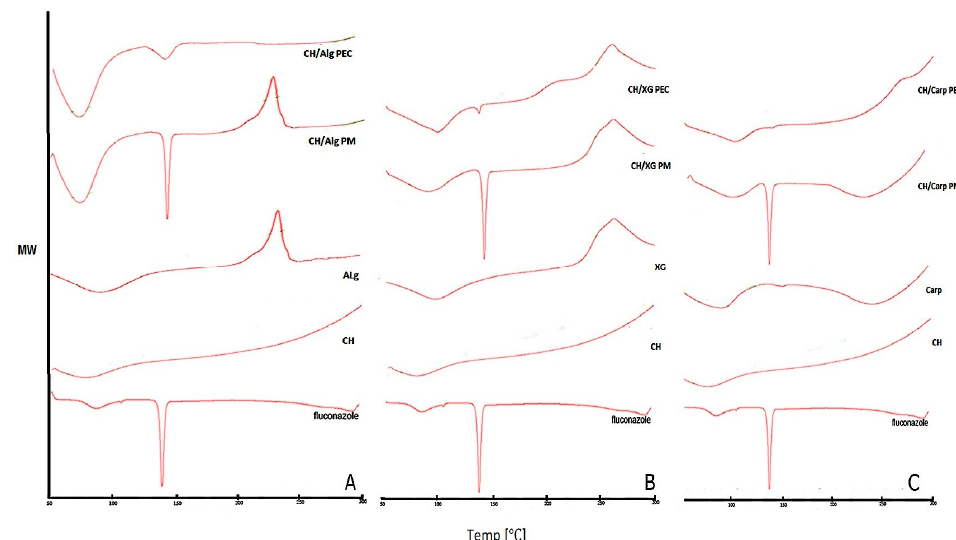
Figure 1. Differential scanning calorimetry (DSC) thermograms of fluconazole, chitosan, anion, their physical mixture (PM) and fluconazole CH/anion polyelectrolyte complex (PEC) ( A ) Na alginate (Alg) ( B ) Carpobol (Carp) ( C ) Xanthan gum (XG).